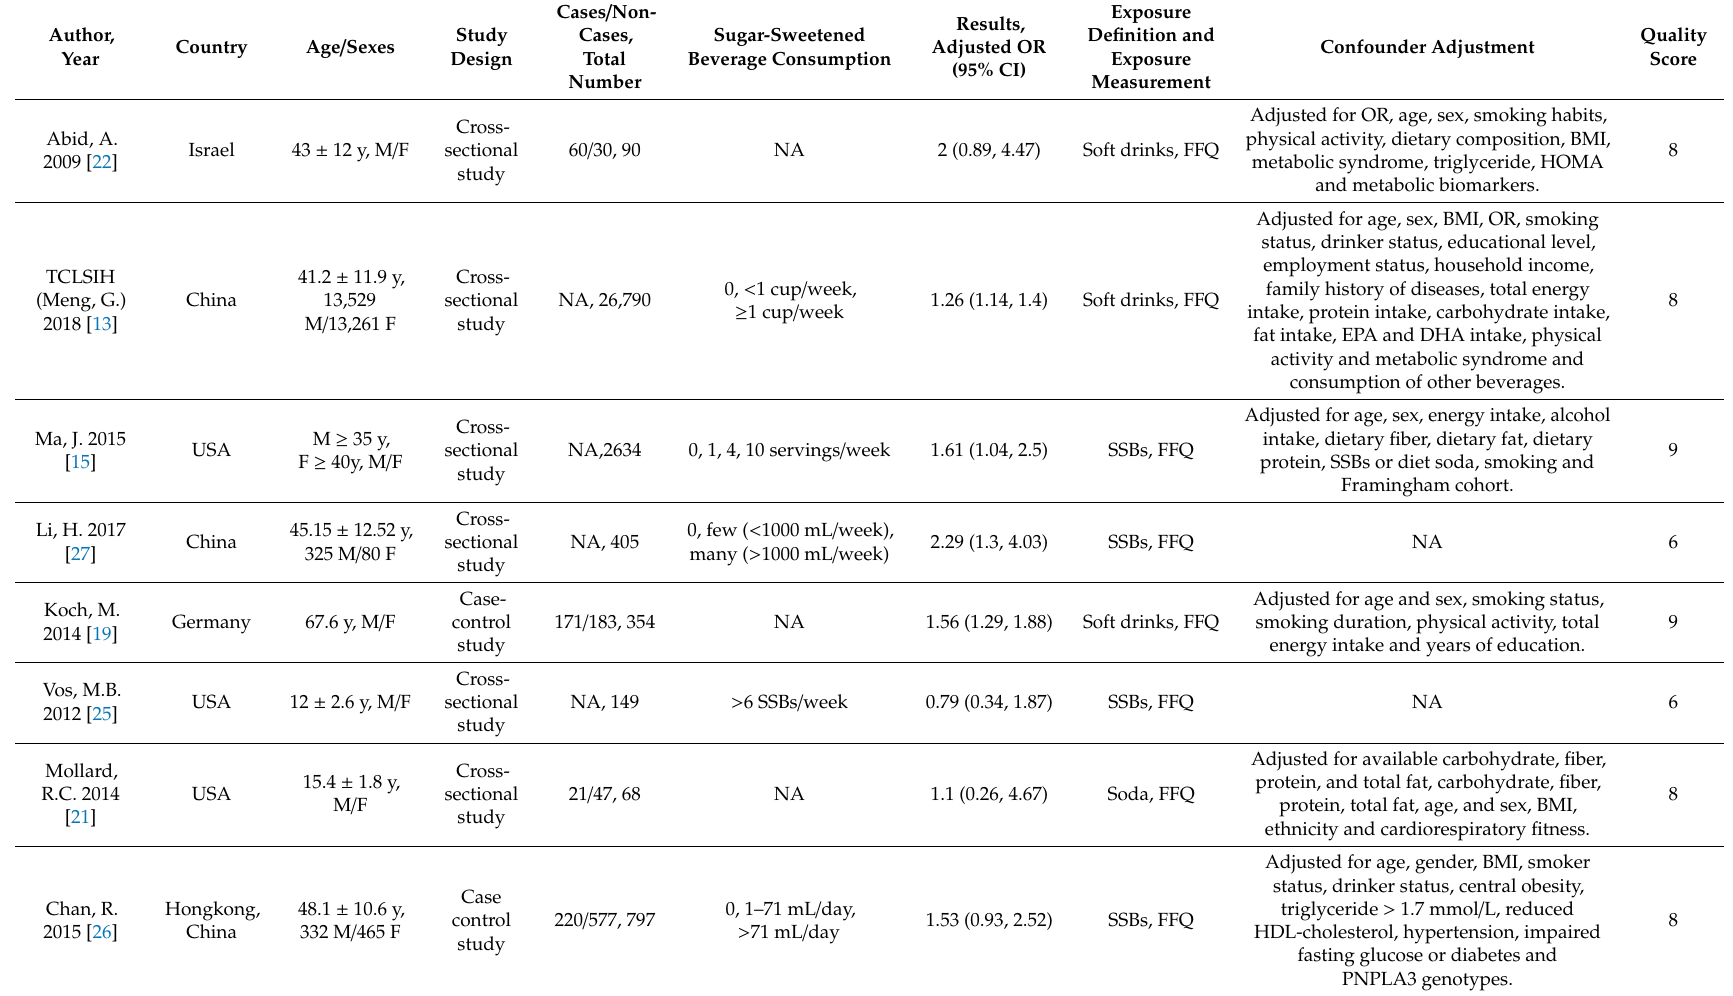
Table 1. Characteristics of all studies included in this